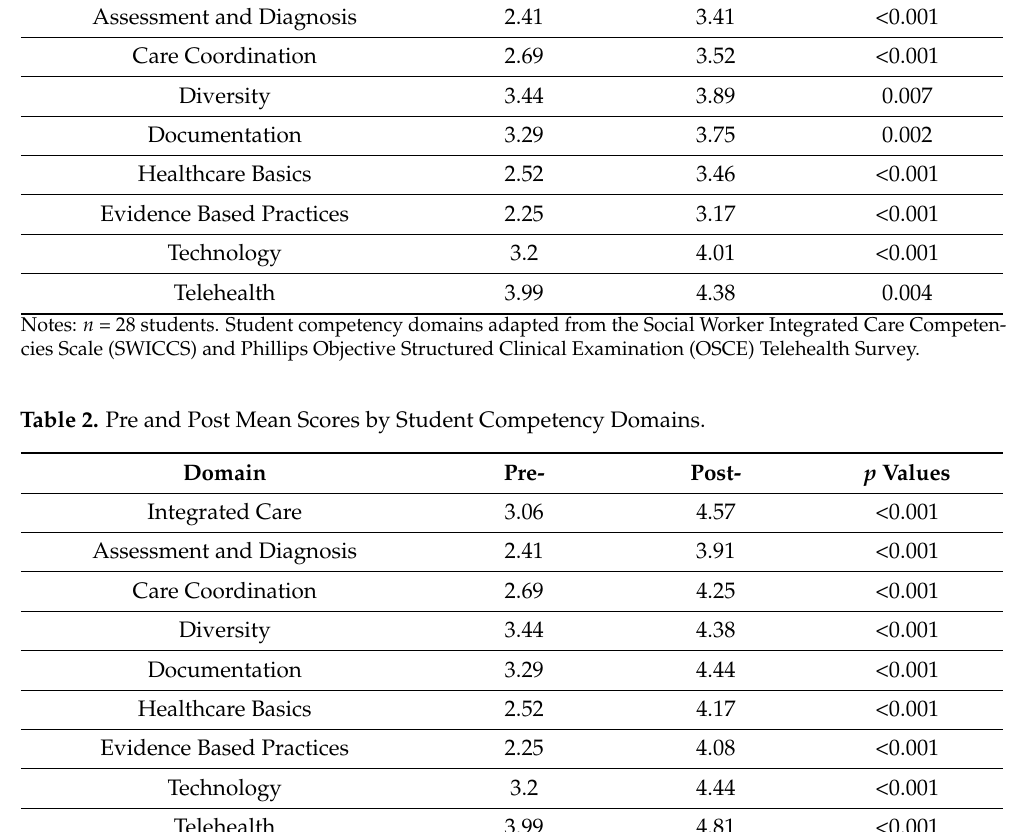
Table 1. Pre and Mid Mean Scores by Student Competency Domains. Domains Pre- Mid- p Values Integrated Care